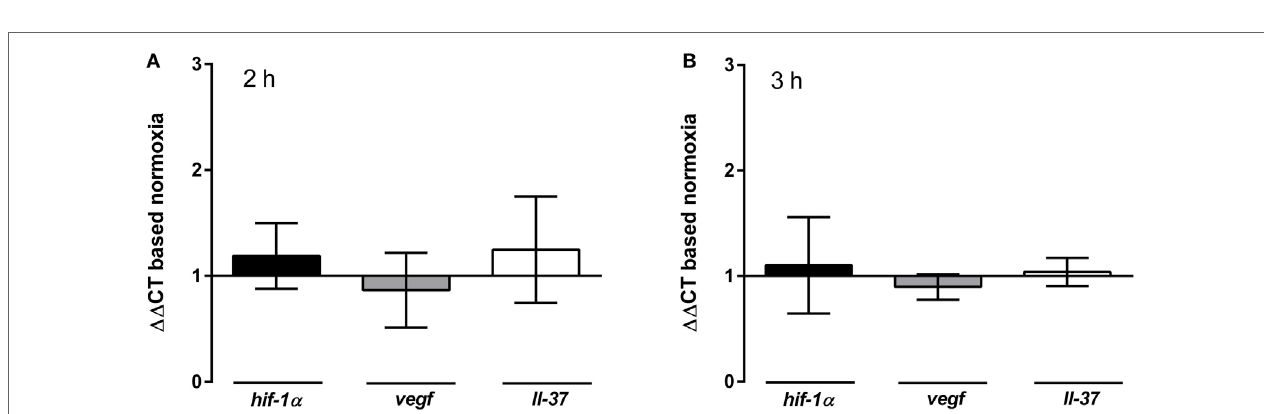
FiGUre 3 | Gene expression of hif-1 α and target genes . Neutrophils were incubated under normoxia or hypoxia for 2 h (a) and 3 h (B) before RNA was isolated and gene expression of hif-1 α and its target genes vegf and ll-37 was analyzed by RT-qPCR. Data were normalized to the non-regulated housekeeping gene rps9 . The x -fold changes of the values from samples incubated under hypoxia were calculated against the normoxic samples. Independent of the time point, there was neither a regulation of hif-1 α nor of its target genes vegf and ll-37 detectable, as all ΔΔ CTs remain below 2 [ hif-1 α : 1.19 ± 0.3 (2 h) and 0.1 ± 0.5 (3 h); vegf : 0.87 ± 0.4 (2 h) and 0.9 ± 0.1 (3 h); ll-37 : 1.25 ± 0.5 (2 h) and 1.0 ± 0.1 (3